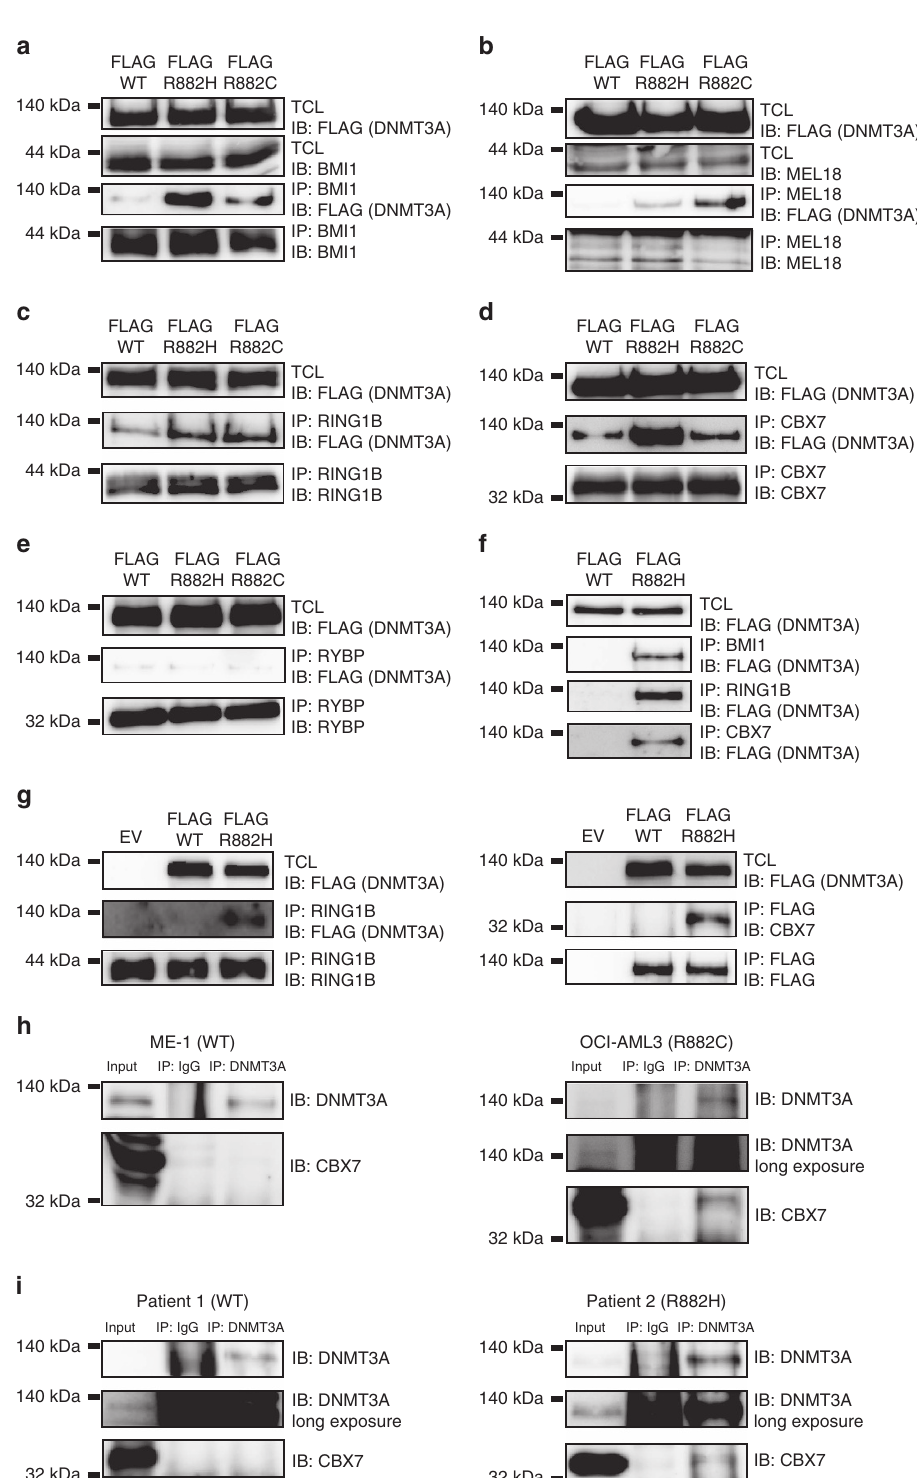
NATURE COMMUNICATIONS|7:10924|DOI: